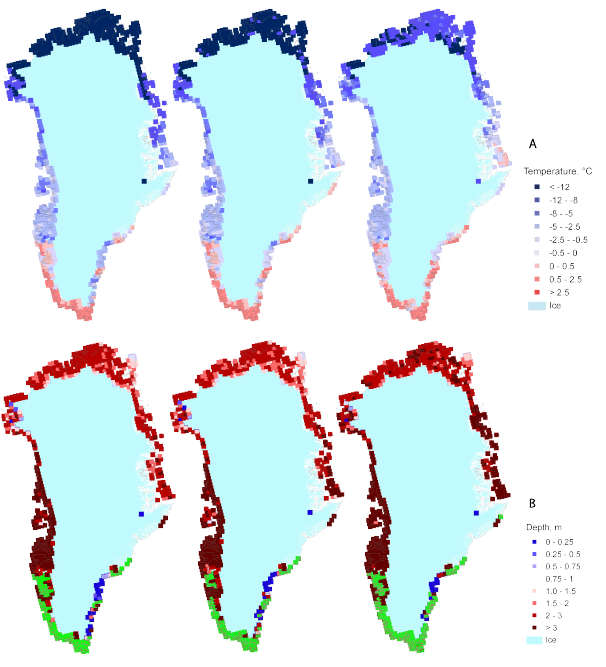
Fig. 5. (A) Annual average ground temperature distribution at 2m depth in sediment with organic layer averaged over the periods 1955–1965, 1995–2005, and 2065–2075. (B) Active layer depth dis- tributions for areas with sediments and organic matter averaged over the periods 1955–1965, 1995–2005, and 2065–2075. The green color represents a permafrost free